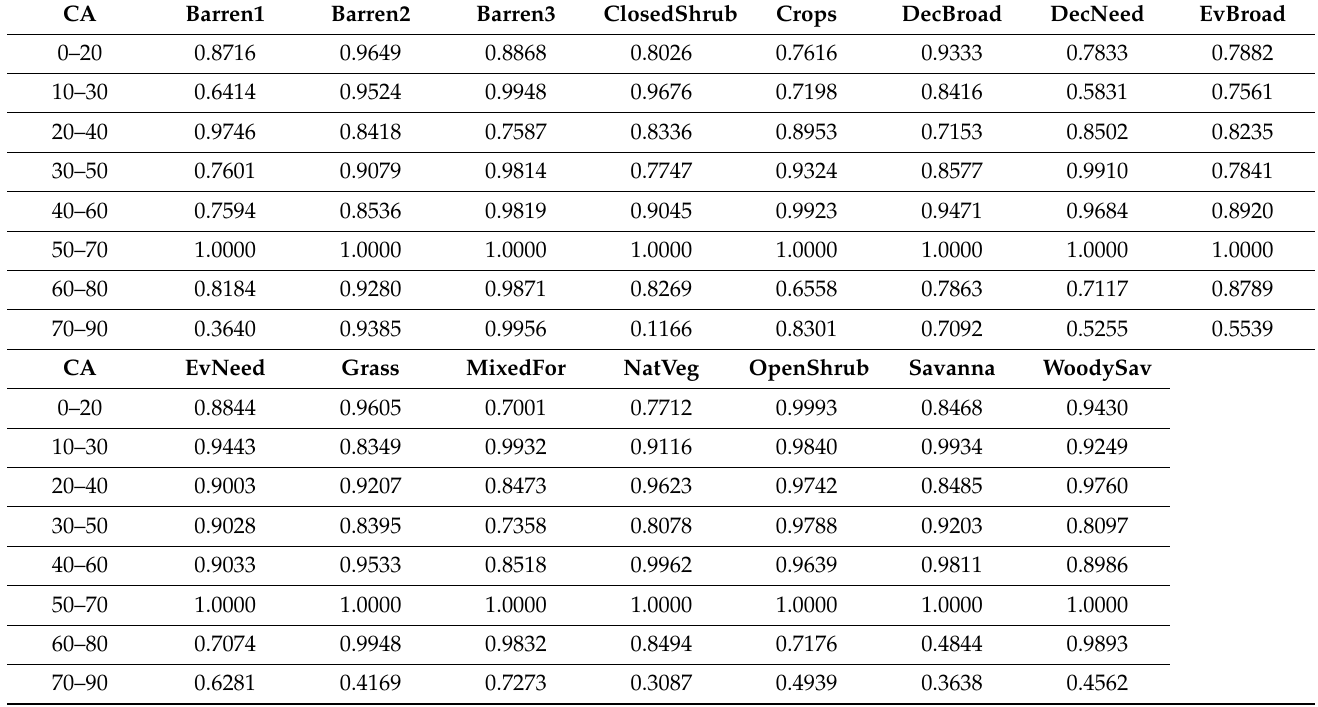
Table A1. CA band VAAD t -test table. Note that any values less than 0.01, or 1%, are